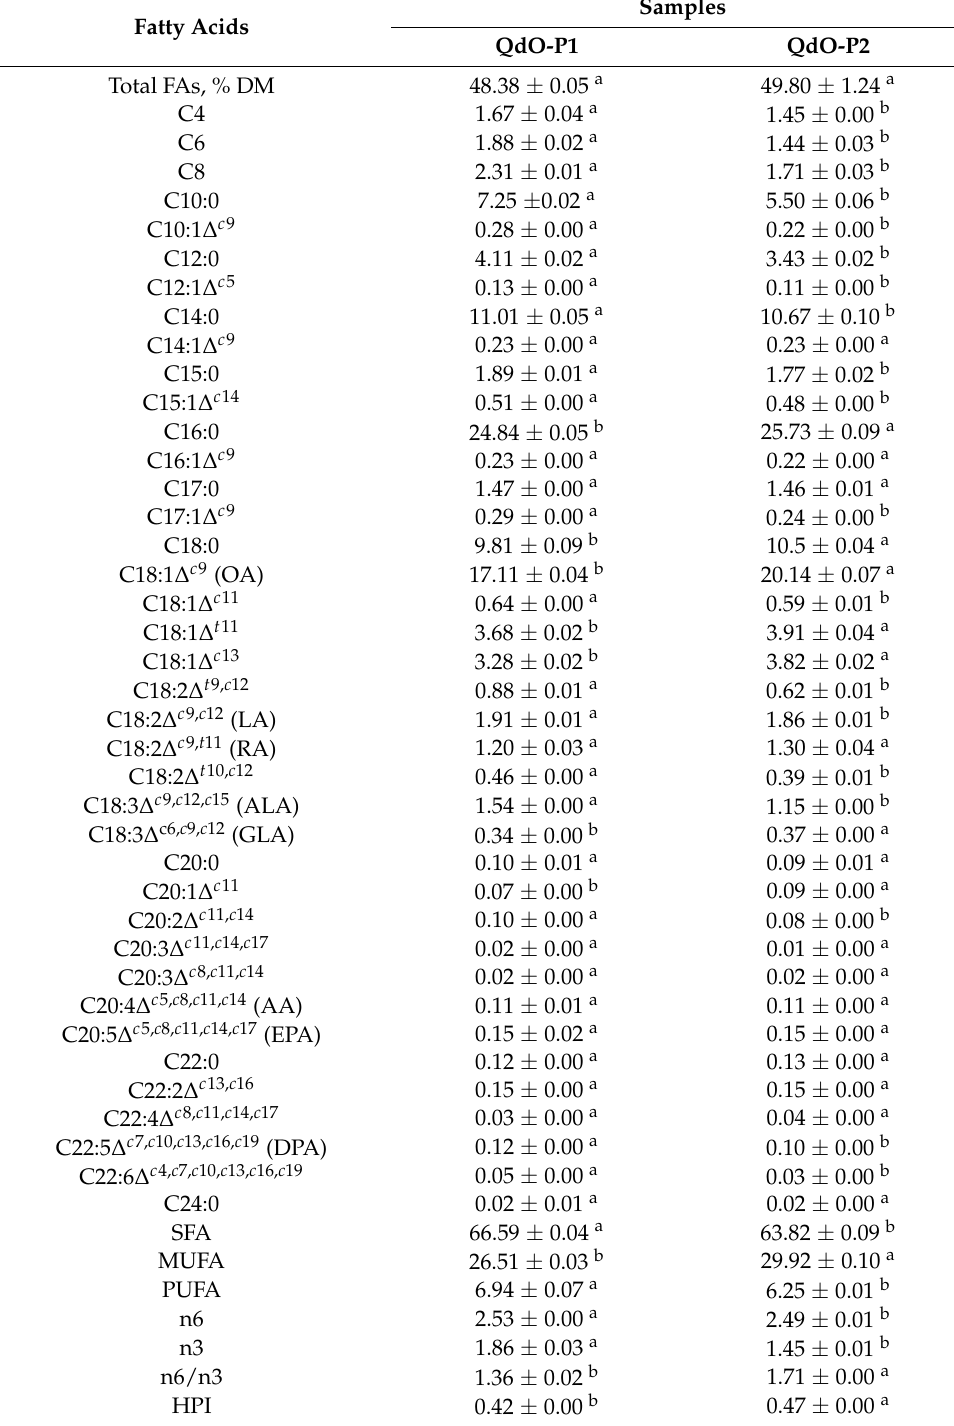
Table 4. Fatty acid profile (g/100 g FA) of Quadrello di ovino cheeses. Fatty Acids